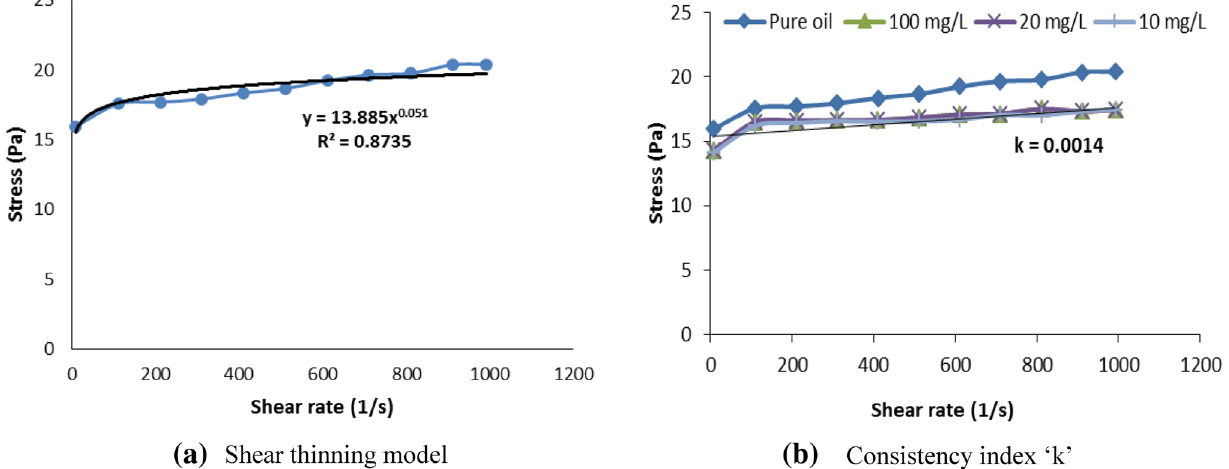
Fig. 14 power function for shear thinning for heavy crude